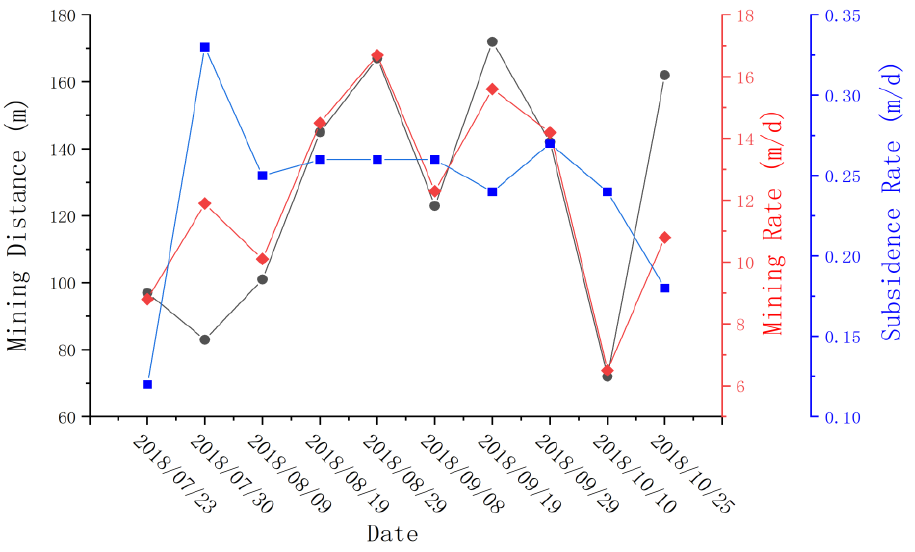
Figure 14. Time series subsidence rate graph. The black vertical axis represents the time node mining distance; the red vertical axis represents the time node average advancement rate; and the blue axis represents the time node average subsidence rate.